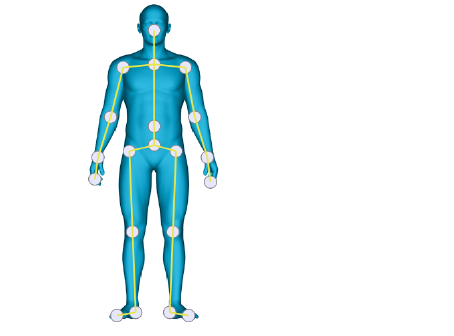
Fig. 3: Mapping of the major joints of the human